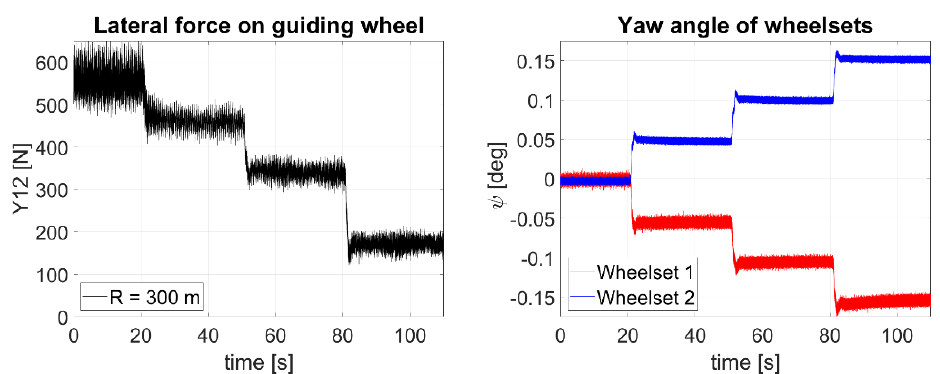
Figure 19. Measured data—active wheelset steering test, R = 300 m.